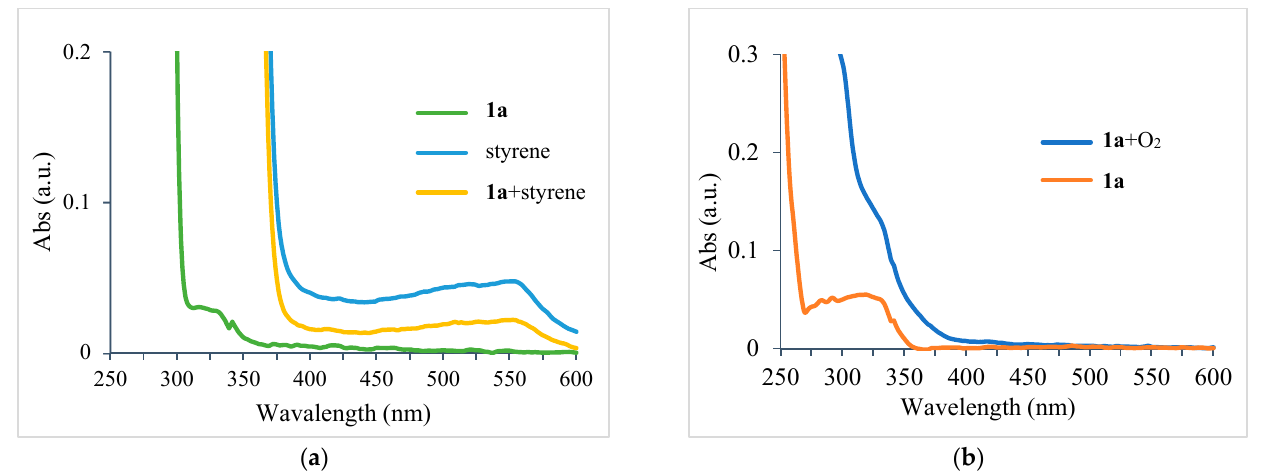
Figure 2. ( a ) UV–vis absorbance spectra of 1a , styrene, and mixture of 1a and styrene in DCM; ( b ) UV–vis absorbance spectra of 1a and mixture of 1a and O 2 in DCM.